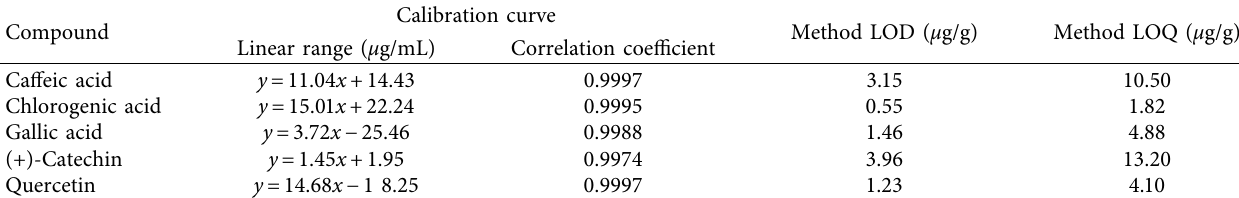
Table 1: Analytical characteristics of the calibration